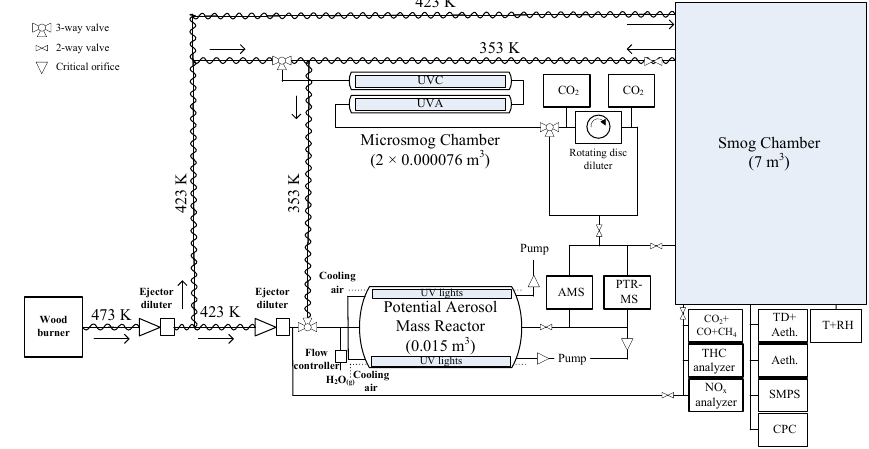
Figure 1. Experimental design for wood-combustion experiments (not drawn to scale). Emissions were sampled through the PAM or MSC, either from the wood burner or from the SC after emission injection. The rotating disc diluter after the MSC and the second ejector diluter before the PAM were only used when sampling from the burner. AMS and PTR-MS measurements alternated among the three systems. TD refers to the thermal desorber upstream of one